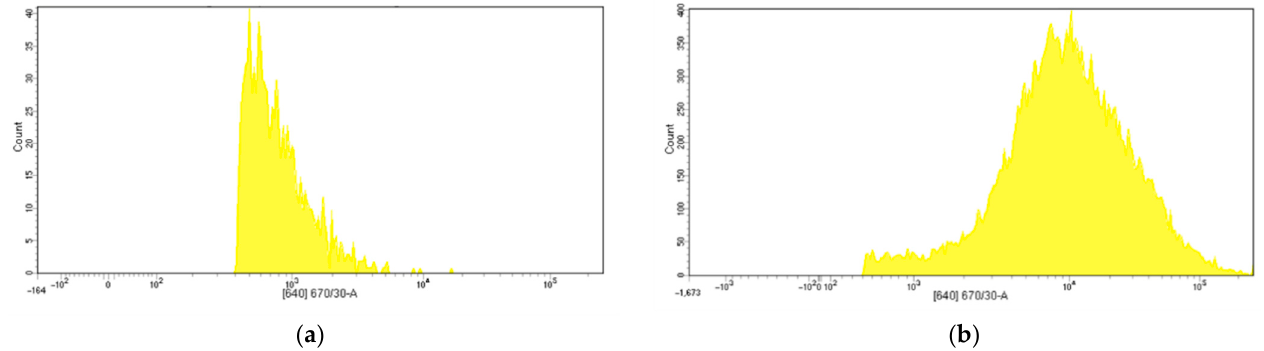
Figure 10. Detection of AF647 using a 640 nm excitation laser through flow cytometry for ( a ) control cell population and ( b ) cells exposed to 50 μ g/mL gold suspension for 24 h. Note the different scales on each graph for the y -axis.